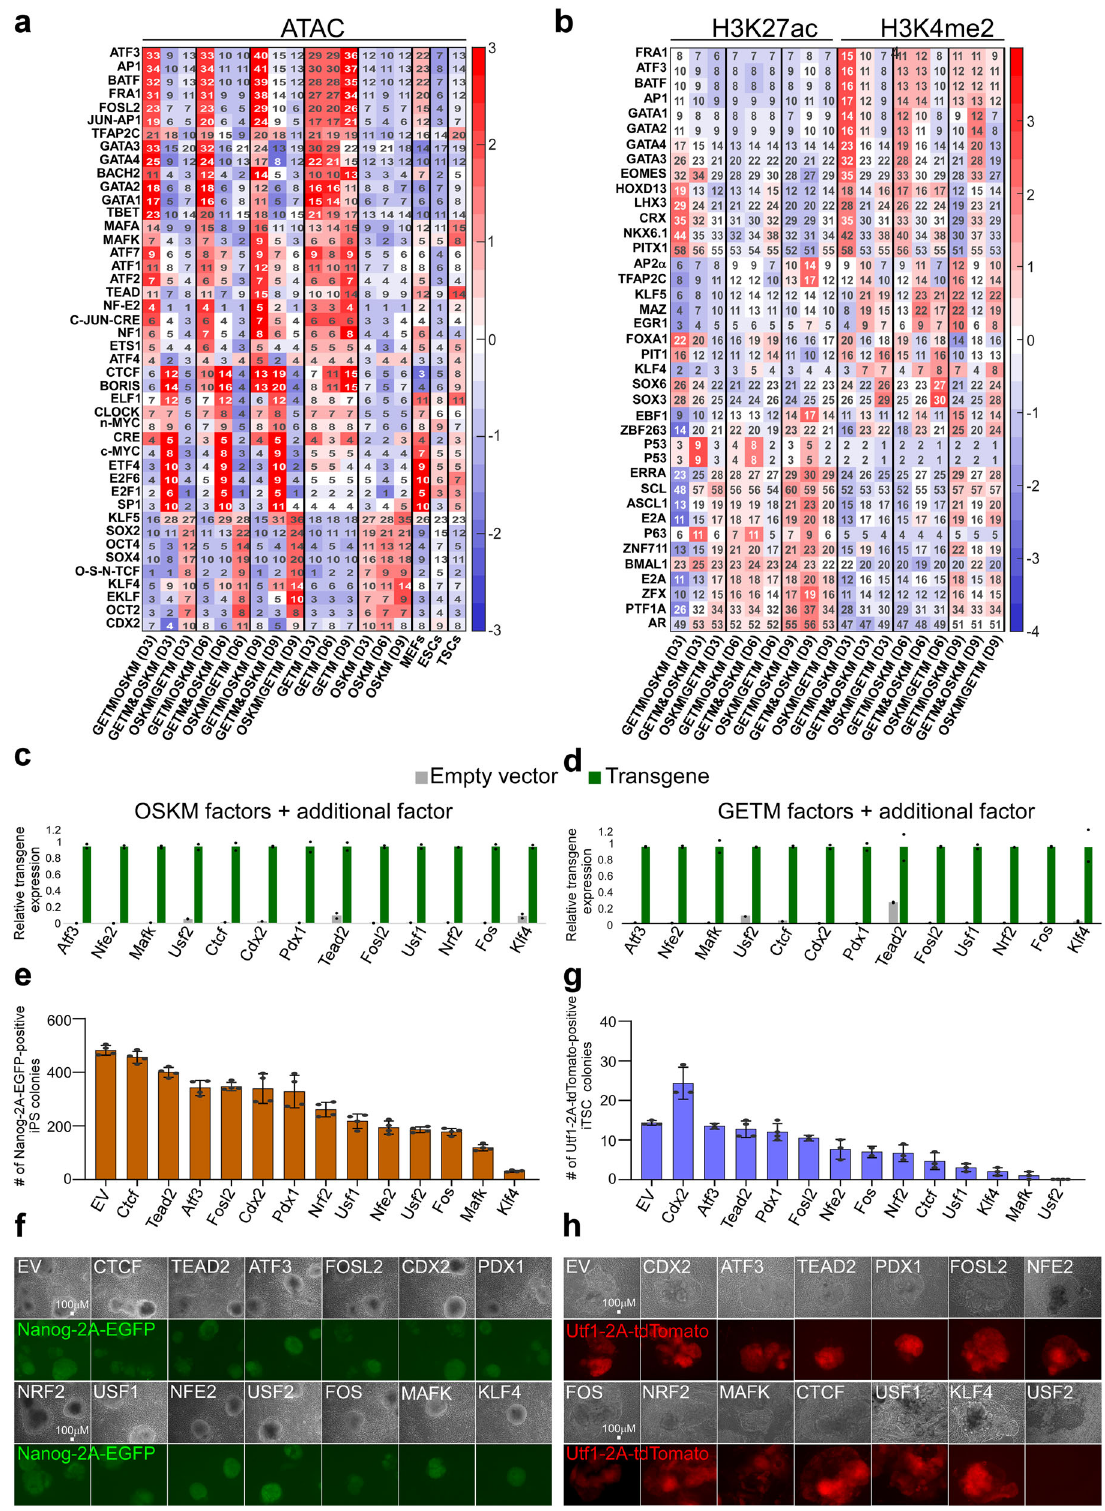
estrogen signaling and insulin signaling, processes that char- acterize both states. In MEFs, the most highly expressed genes participate in protein processing in ER, EGFR1 signaling, cyclic nucleotide catabolism and cell junction assembly. In contrast, clusters 5,7,11, which are also shared between OSKM and GETM reprogramming but are enriched with smaller peaks around the TSS as in intergenic and intronic regions, contain binding sites,